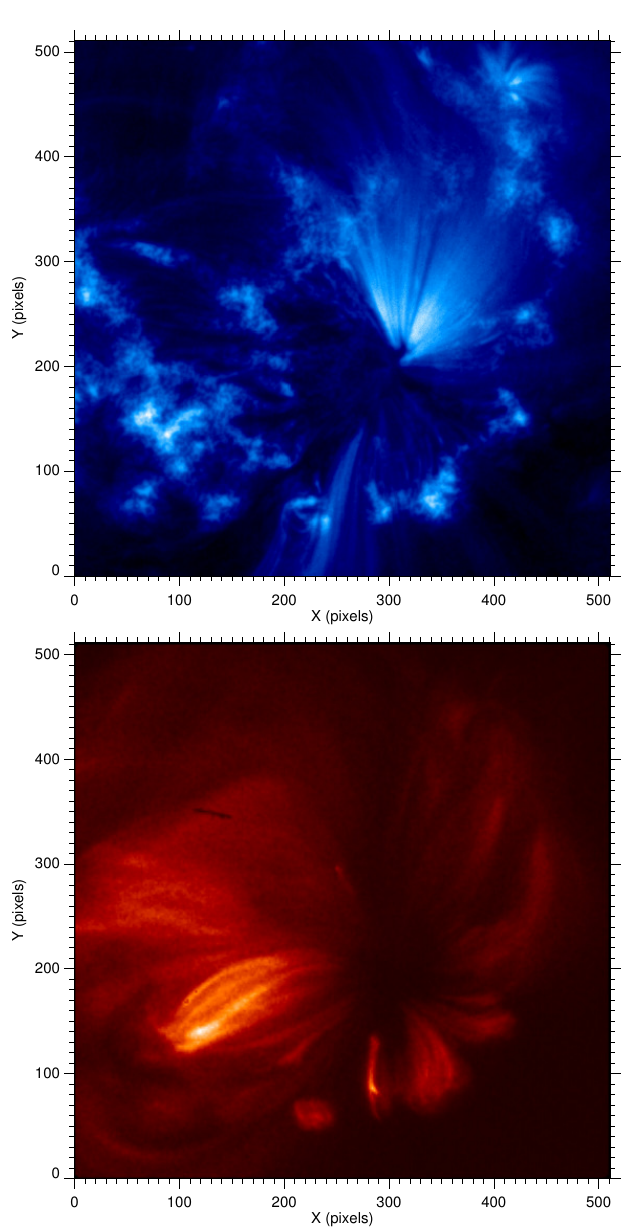
Figure 1: Images of the same active region, taken in the EUV band with TRACE (top) and in the X-ray band with Hinode/XRT (bottom), on 14 November 2006. The X-ray image shows more clearly that the active region is densely populated with coronal